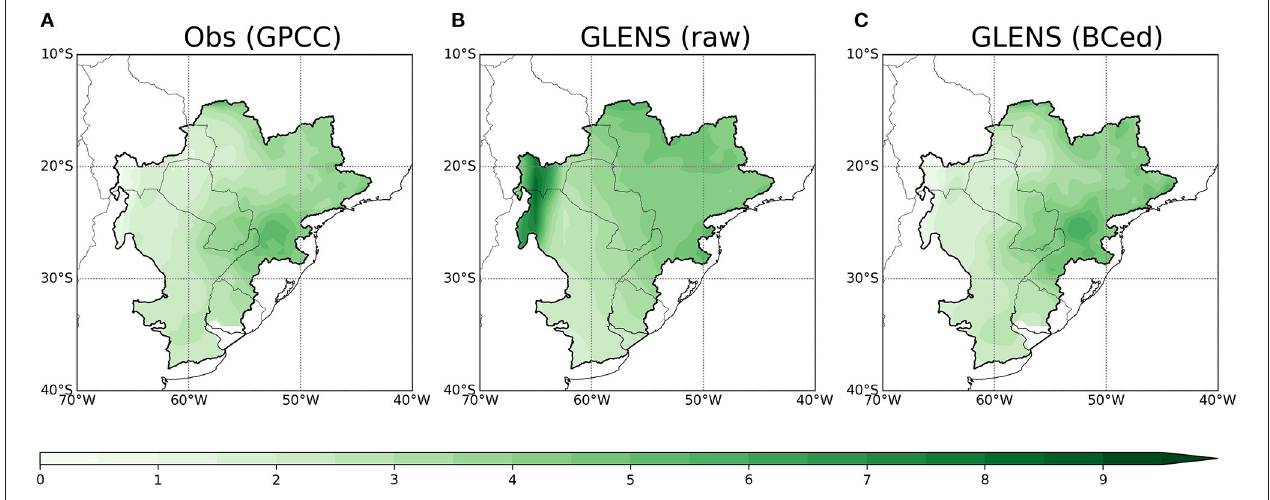
FIGURE 6 | Annual (A) observed, (B) simulated, and (C) bias-corrected precipitation (mm/day) for the validation period